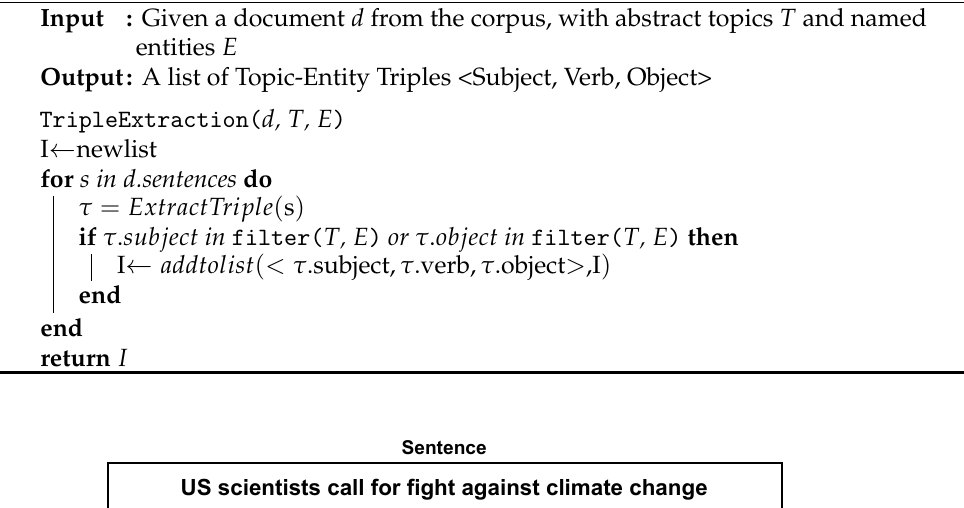
Algorithm 1: Triple Extraction Algorithm from Raw Text